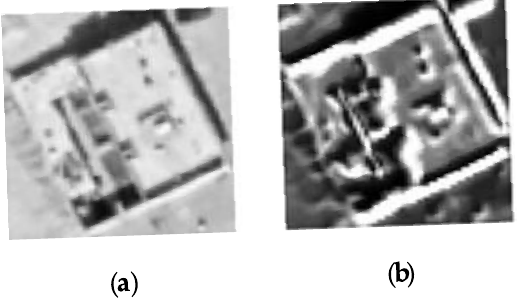
Figure 5. A sample for building image enhancement using SG layer: ( a ) Before SG layer; ( b ) After SG